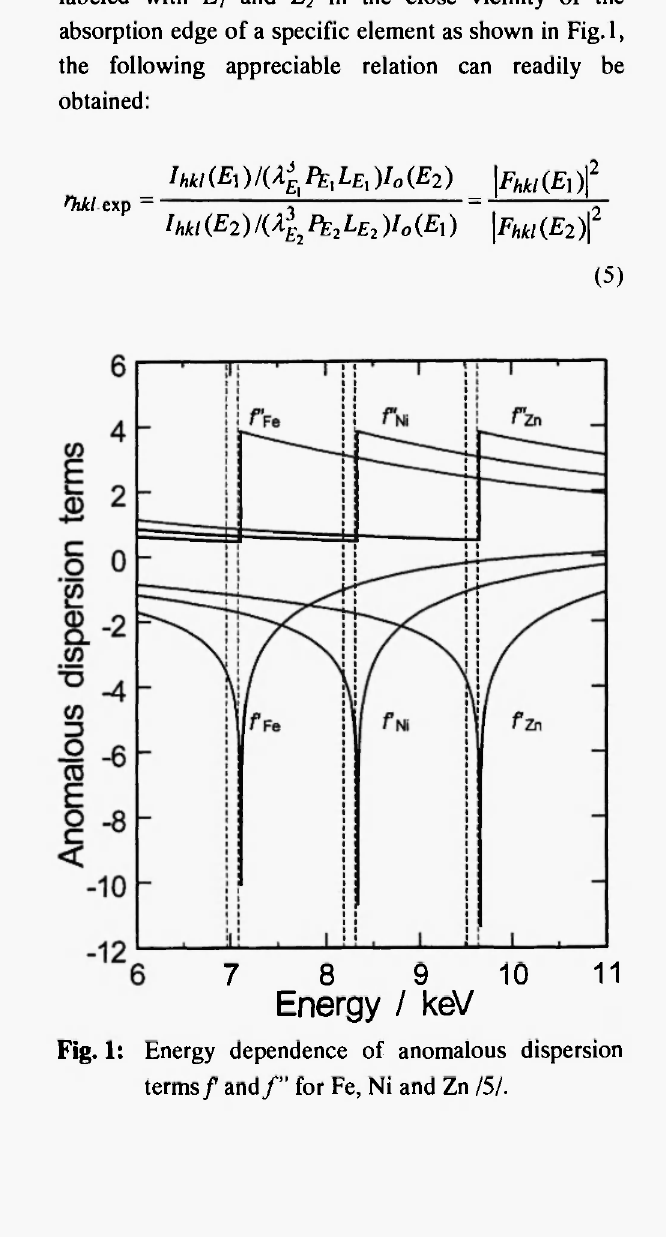
Fig. 2: Variations of the integrated intensity ratio r hklal \ at the Zn Κ absorption edge as a function of the inversion parameter χ for the ZnFe 2 0 4 sample annealed at 773 Κ for 72